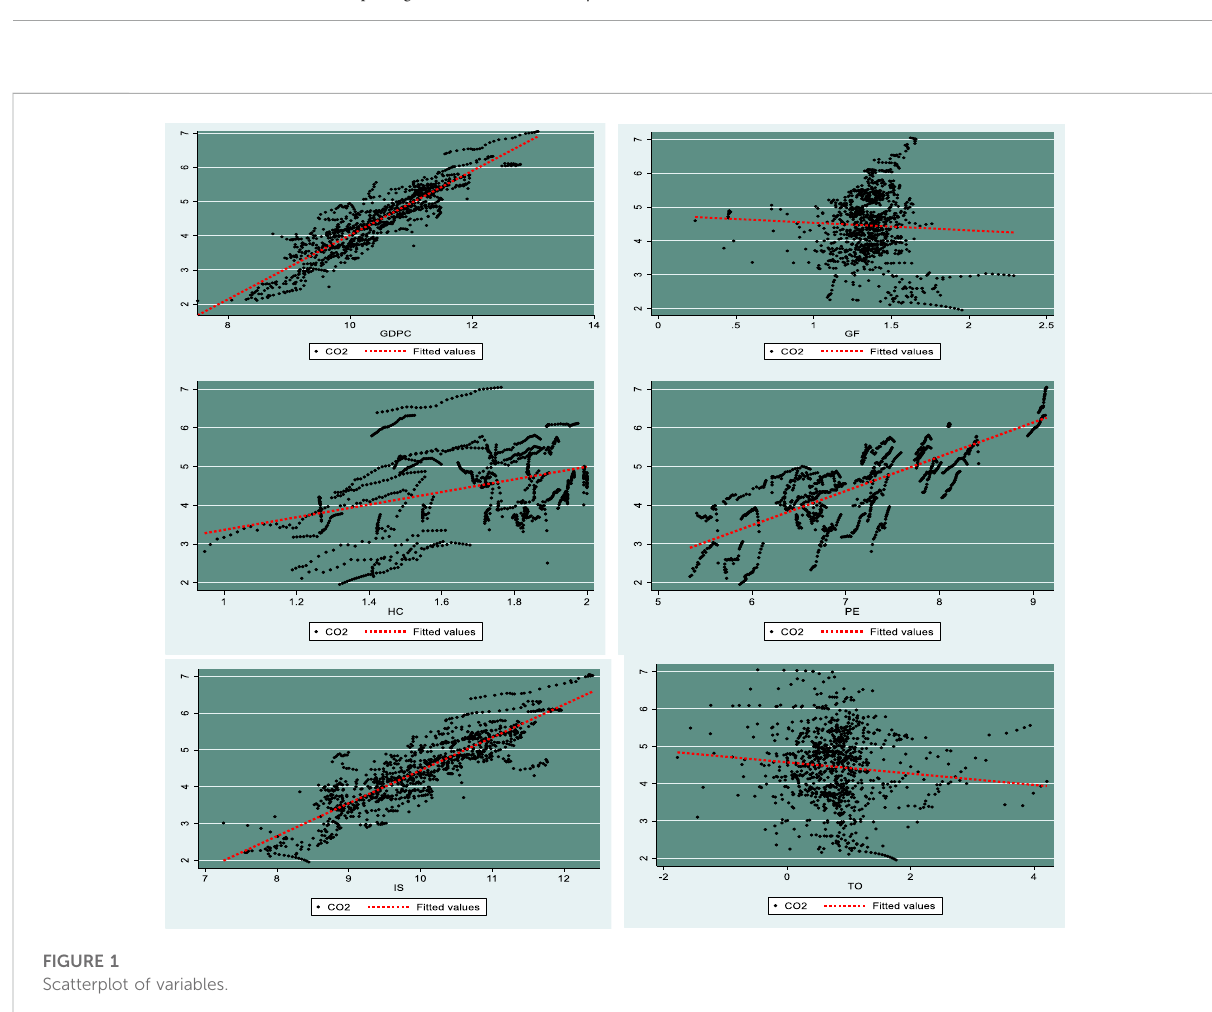
FIGURE 1 Scatterplot of